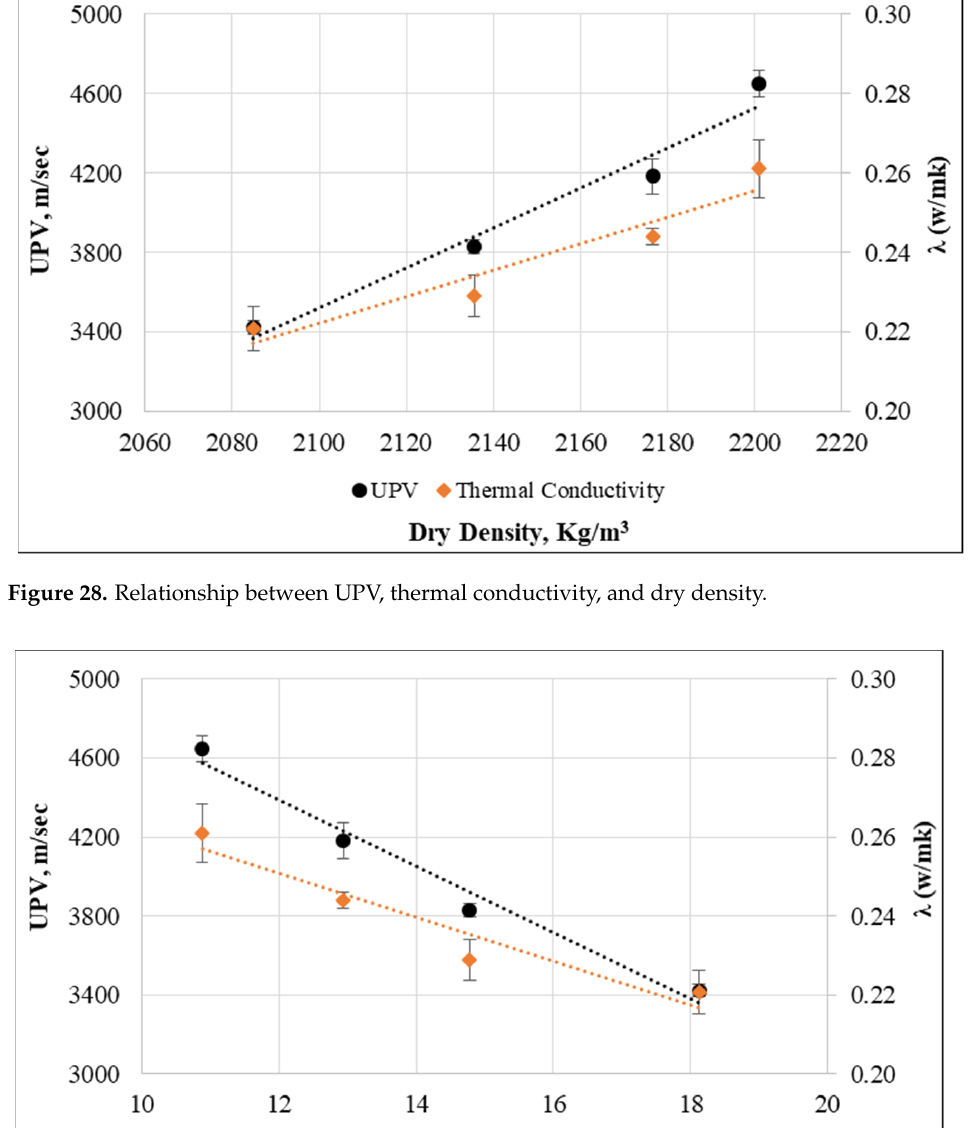
R-squared correlation coefficient values of 0.92 and 0.97, respectively, indicating a strong relationship between the variables.